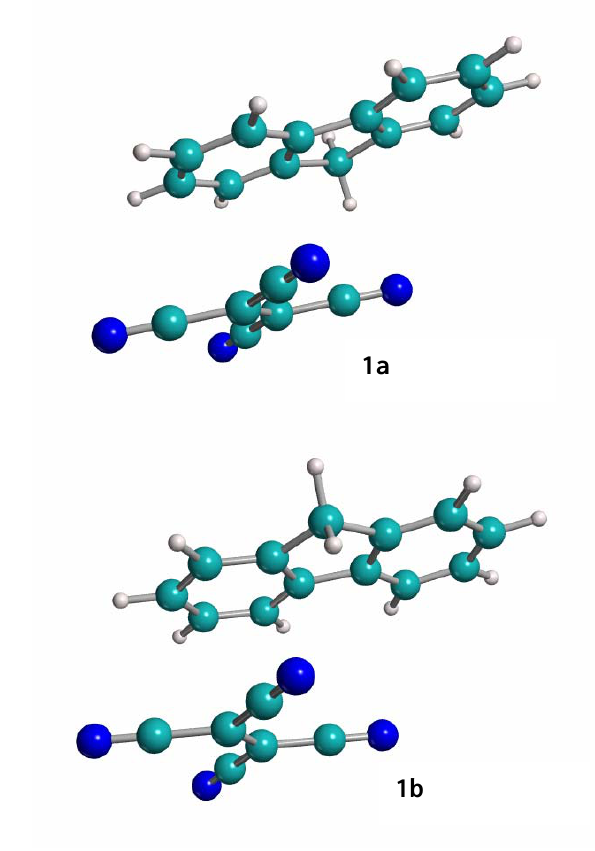
Figure 2. Sketch of the graphical separation process used to obtain the two distinct ordered structures from the disordered crystal structure of 1 , where the black and white bonds indicate the 1a and 1b positions